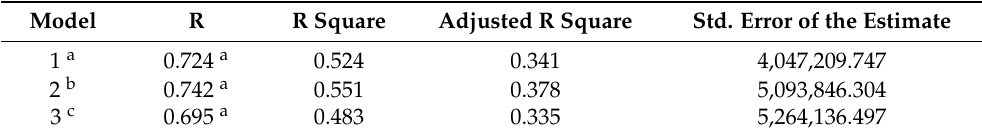
Table 8. Model summaries.